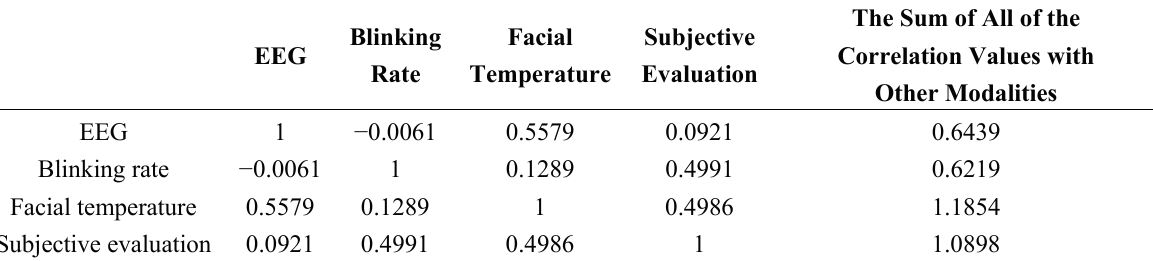
Table 10. Confusion matrix and the sum of correlation values between